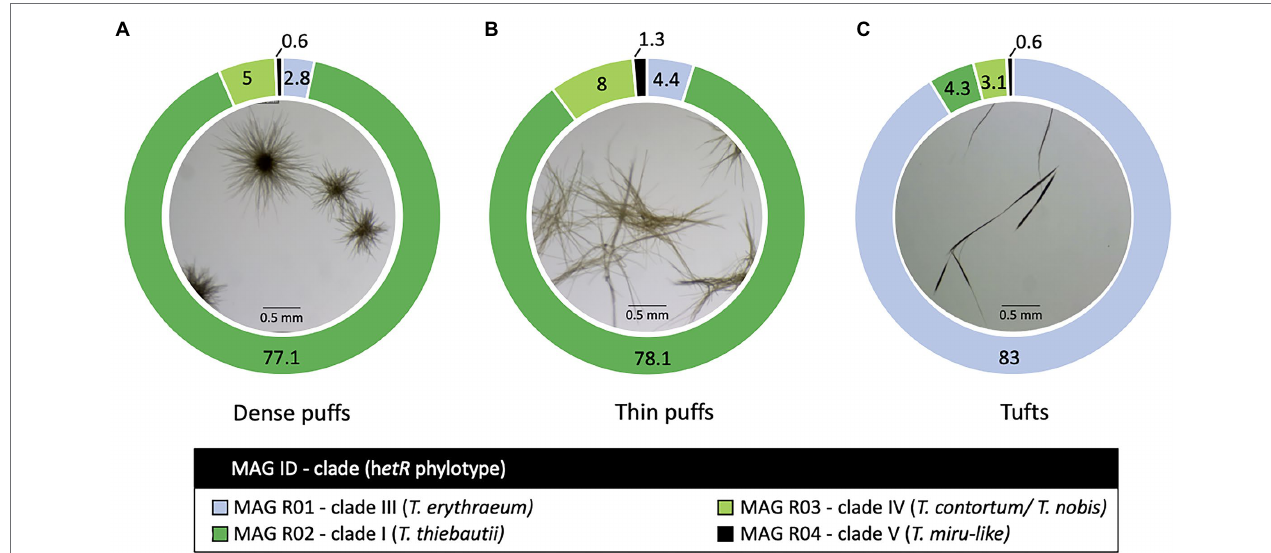
FIGURE 1 | Trichodesmium colony morphotypes and their relative read abundance (%) in the Red Sea. Both (A) dense and (B) thin puff-shaped morphotypes, primarily consisted of Trichodesmium thiebautii genotype (dark green; MAG R02), while tuft-shaped morphotypes (C) were dominated by Trichodesmium erythraeum (light blue; MAG R01). All morphotypes contained low read abundance of non-diazotrophic MAG R03 (light green; MAG R03) and MAG R04 (black; MAG R04) genotypes, clustering within clade IV and V